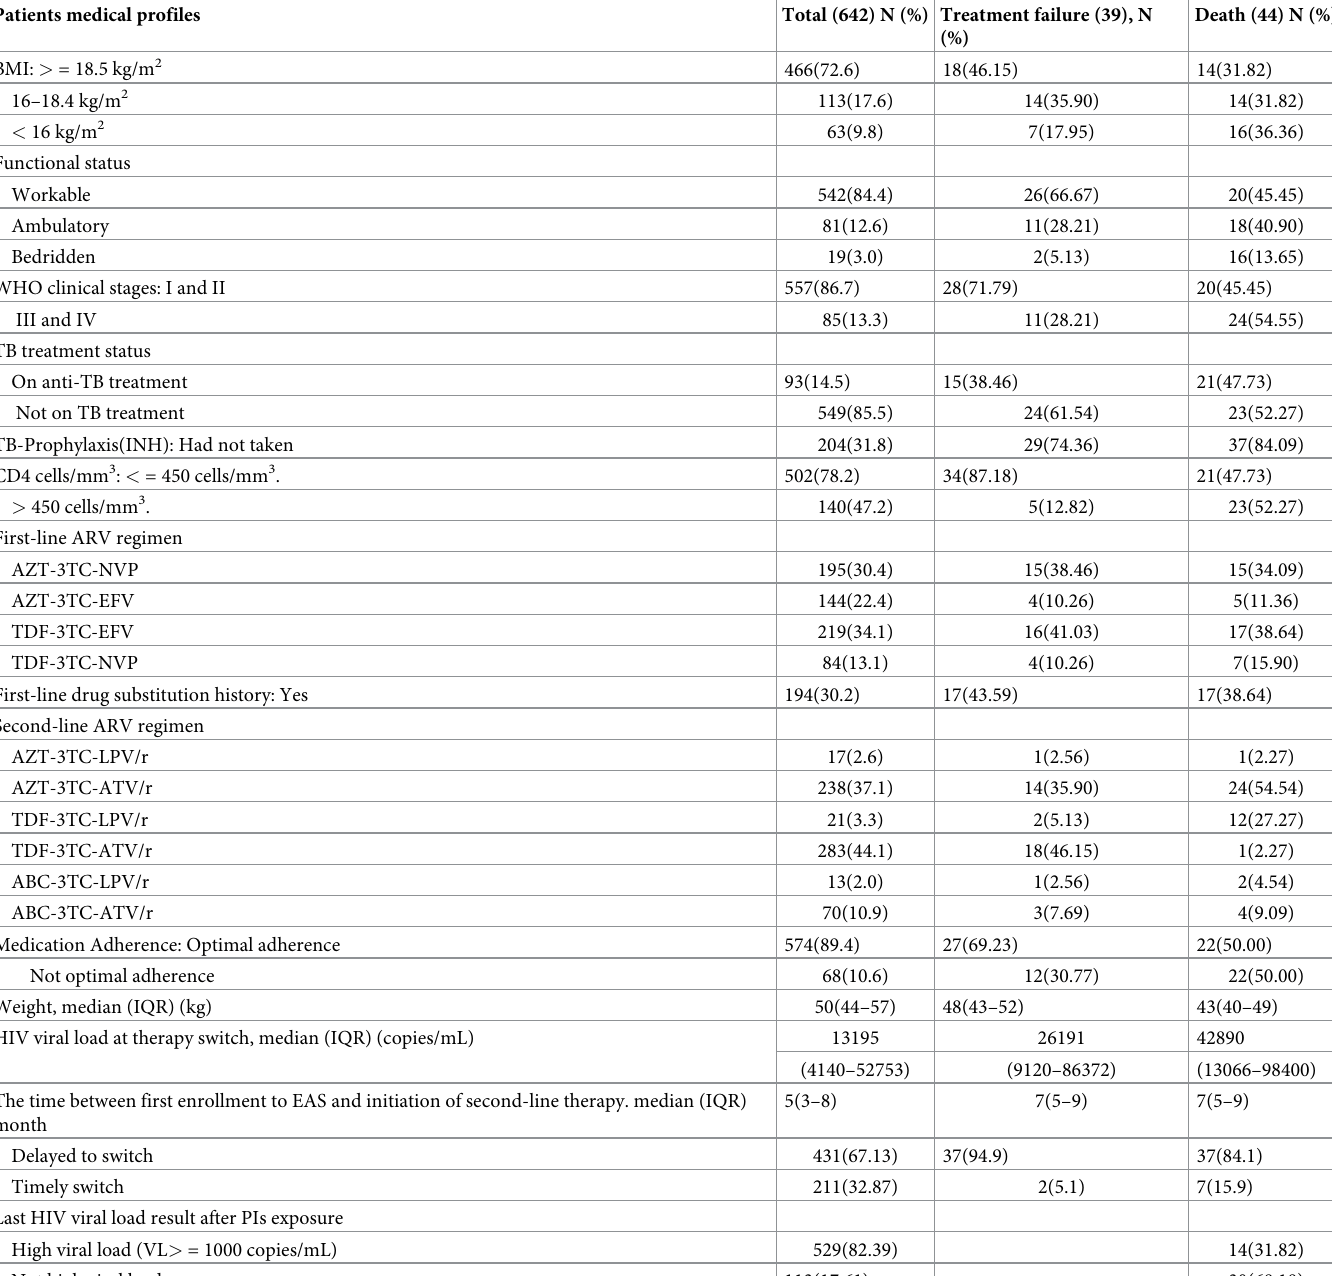
Table 2. Clinical characteristics of PLWHIV on second-line antiretroviral therapy, at Dessie Comprehensive Specialized Hospital, northeast Ethiopia, October 2016—November 2019. Patients medical